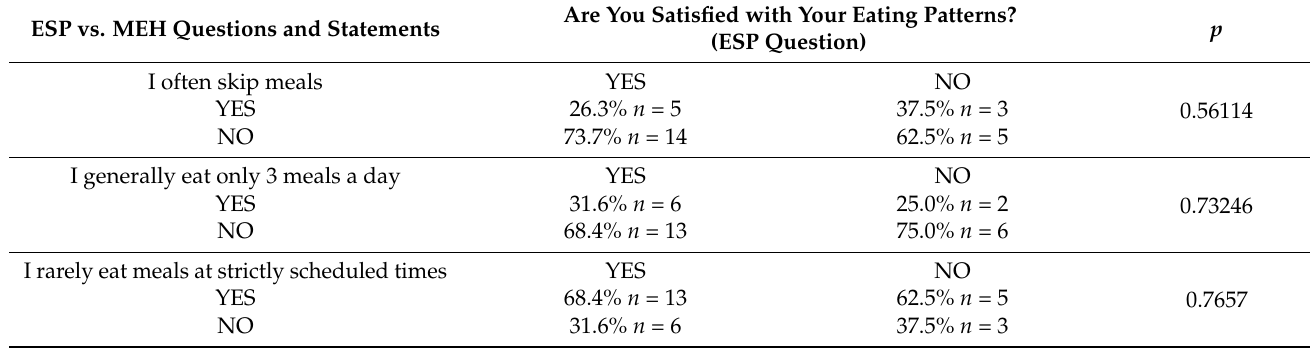
Table 15. The distribution of responses selected from the “My Eating Habits” questionnaire in accordance with the satisfac- tion with eating patterns in males.